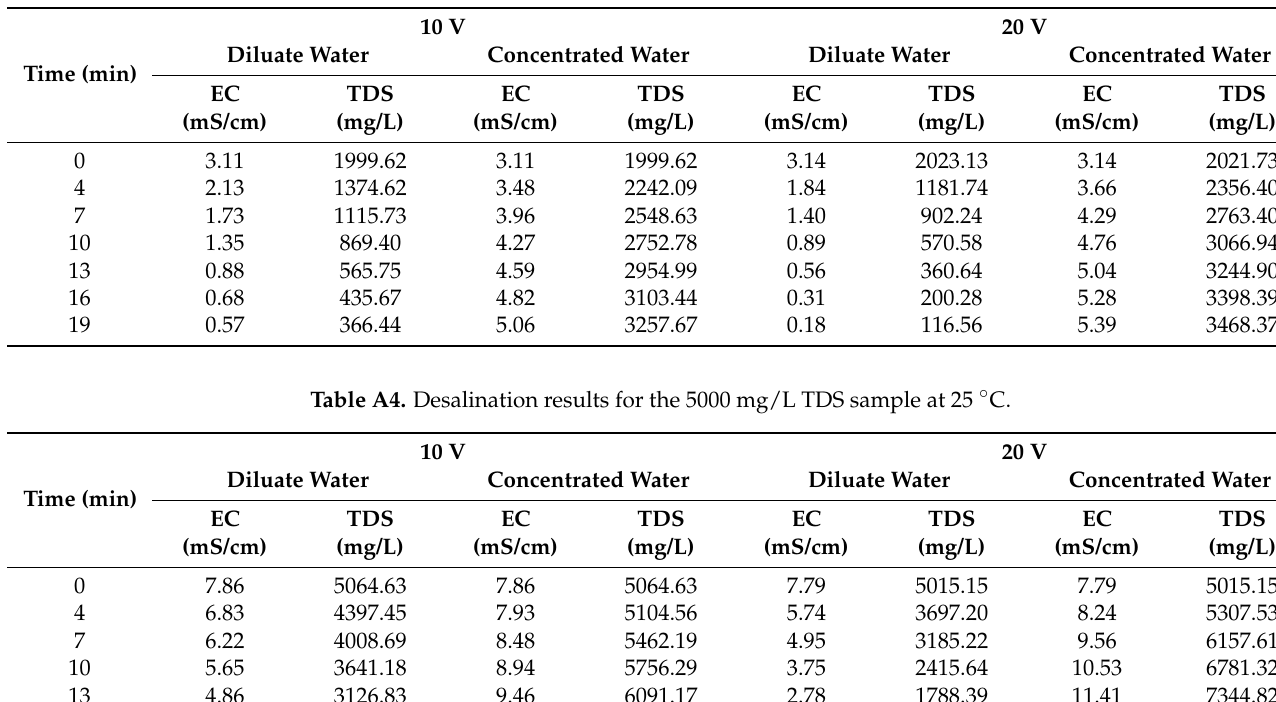
Table A3. Desalination results for the 2000 mg/L TDS sample at 35 ◦ C.